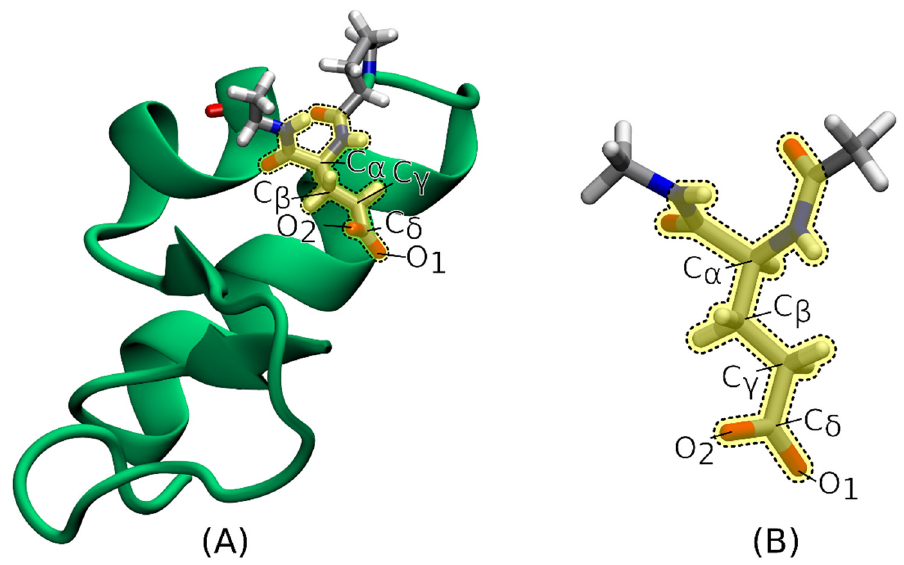
Figure 4. ( A ) Glutamate residue and its neighboring atoms (both depicted in licorice representation) in the protein crambin (mainly depicted in cartoon representation), with the labels indicating the glutamate atoms for which the 1s core-ionization energies were computed at IMOM/ELMO level; ( B ) reduced model system used for the IMOM/ELMO and fully IMOM calculations performed on the isolated glutamate residue. In both cases the QM region is highlighted in yellow and framed by a dotted line.